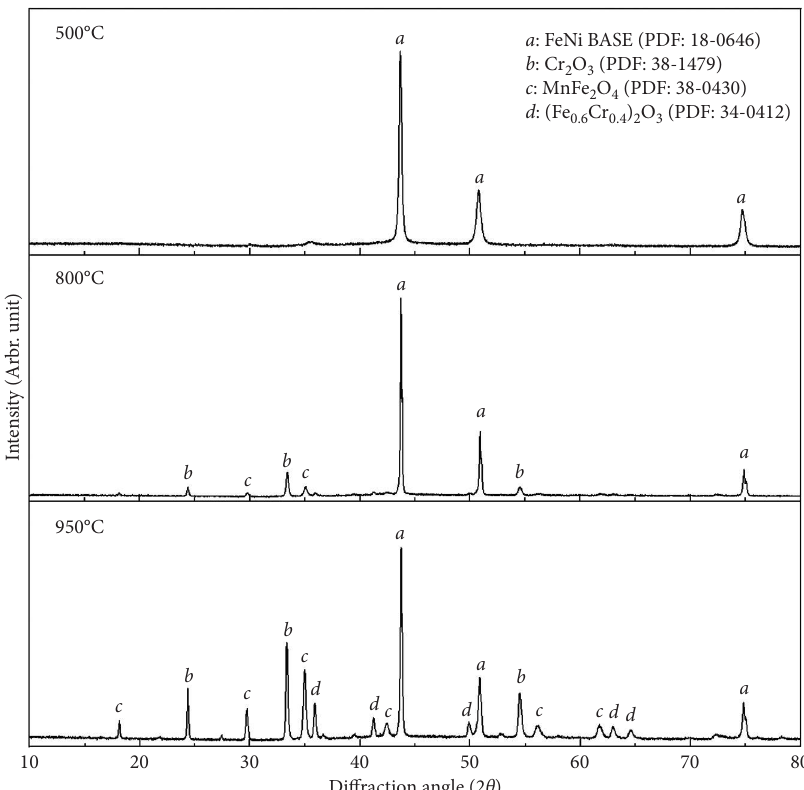
Figure 6: Grazing XRD analysis of Incoloy 800H surface in impure helium at 500 ° C, 800 ° C, and 950 ° C.